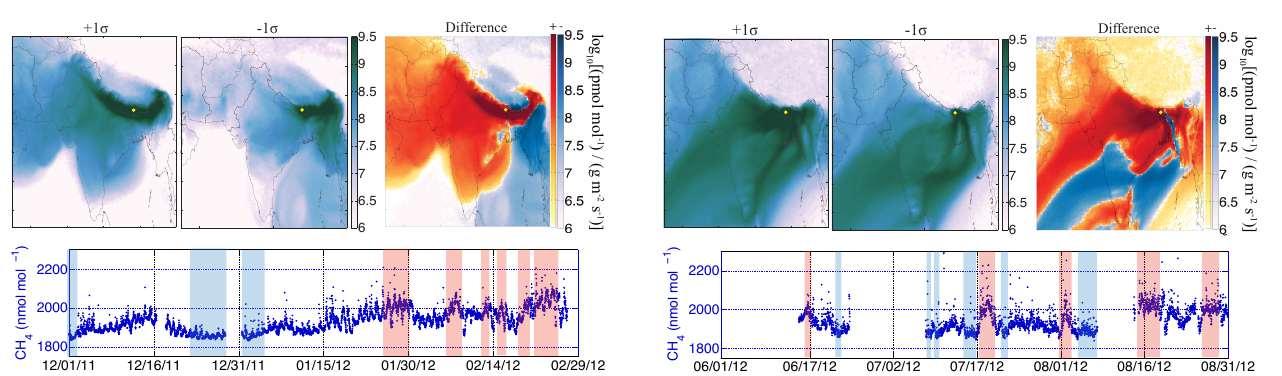
Fig. 7. Same as Fig. 6 but for June 2012 through August